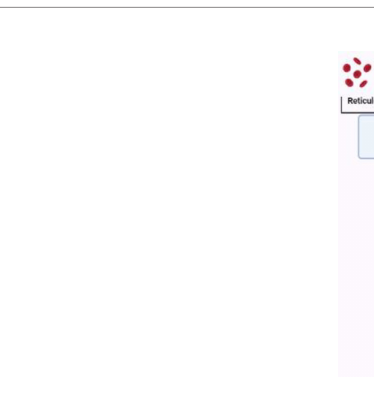
FIGURE 1 | The biology of exosomes. Exosomes are vesicles with a diameter of 40 to 100 nm that may be produced by various cells and extracted from multiple bodily fl uids. Exosomes may provide information to receptor cells via plasma membrane fusion, phagocytic endocytosis, or cell – receptor contact (BioRender.com was used to create this fi